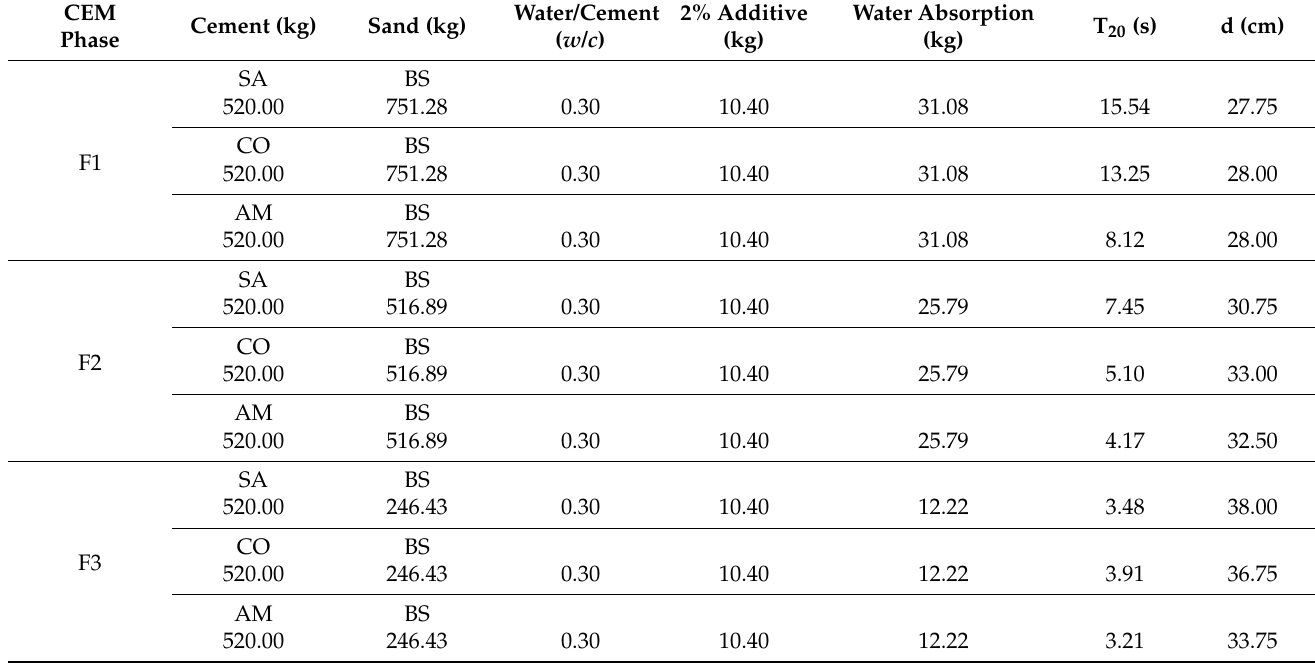
Table 11. Tests using the Abrams mini cone of equivalent mortar detailed in Tables 8–10, with normalized concrete according to the recommendation of Colegio Oficial de Ingenieros Civiles (Quito, Ecuador) was selected (Table